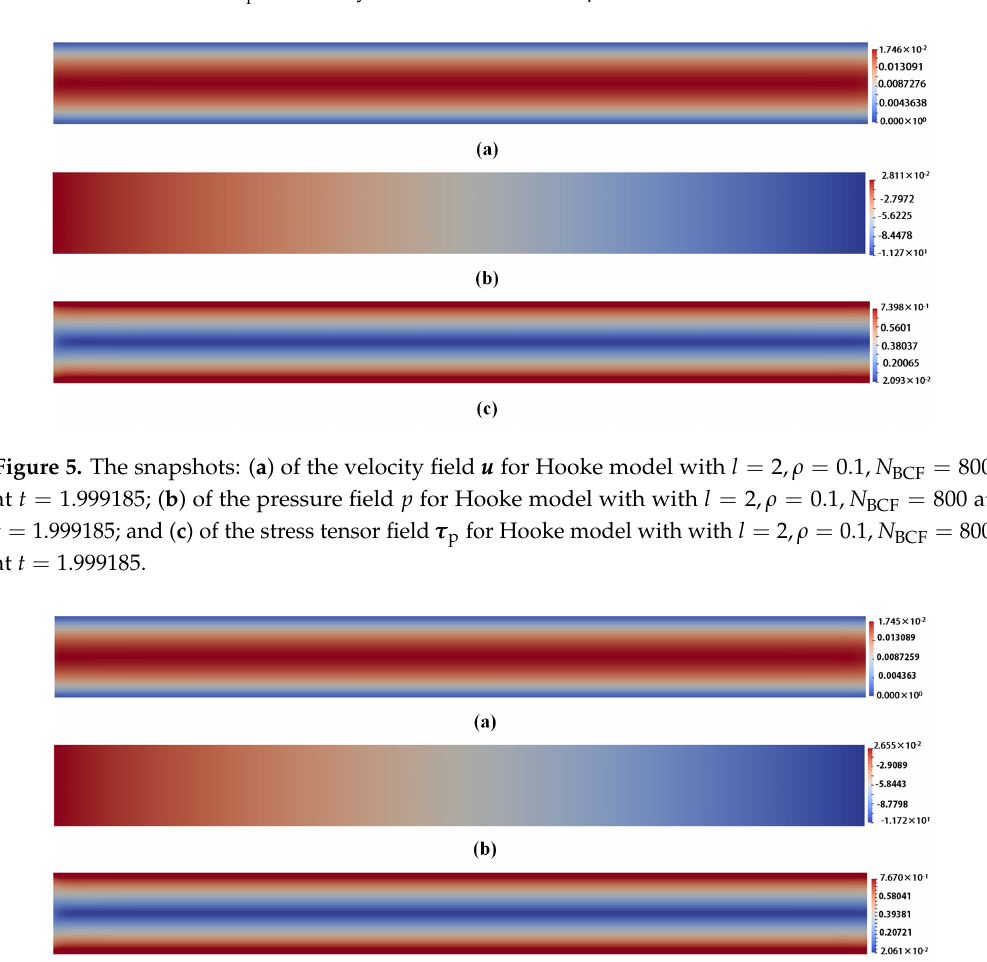
Figure 4. The snapshots: ( a ) of the velocity field uuu for Oldroyd-B model with l = 2, ρ = 0.1 at t = 1.999185; ( b ) of the pressure field p for Oldroyd-B model with l = 2, ρ = 0.1 at t = 1.999185; and ( c ) of the stress tensor field τττ p for Oldroyd-B model with l = 2, ρ = 0.1 at t = 1.999185.